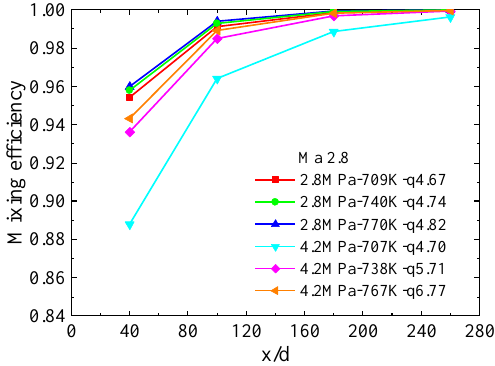
Figure 17. Mixing efficiency at different injection conditions.